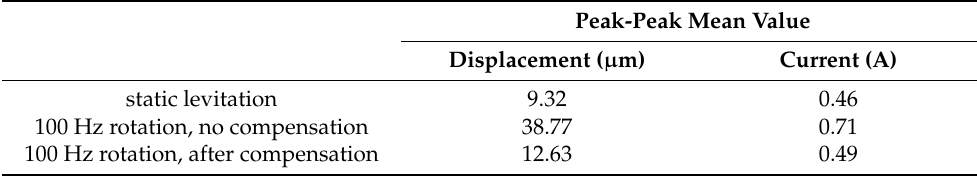
Table 1. Rotor Displacement and Current Peak-Peak Mean Value.